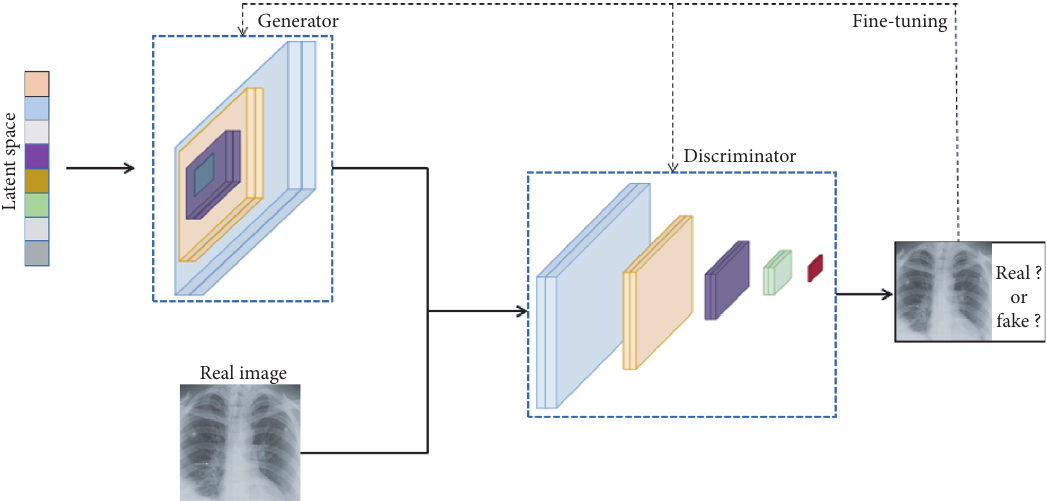
Figure 3: Illustration of a GAN classifier with the generator and discriminator